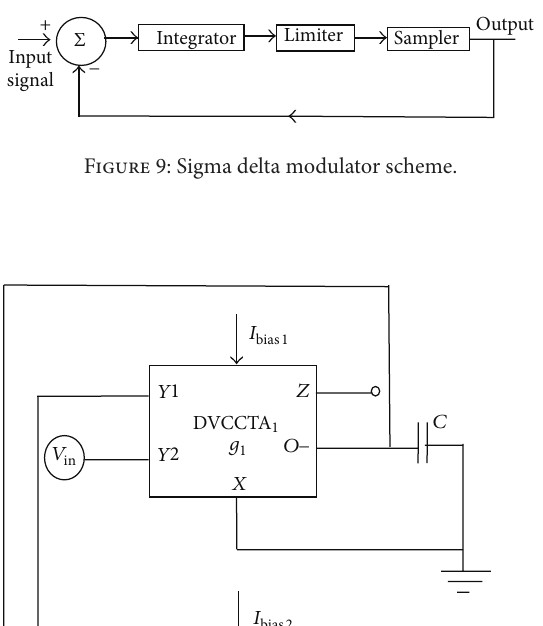
Figure 8: Proposed delta modulator.